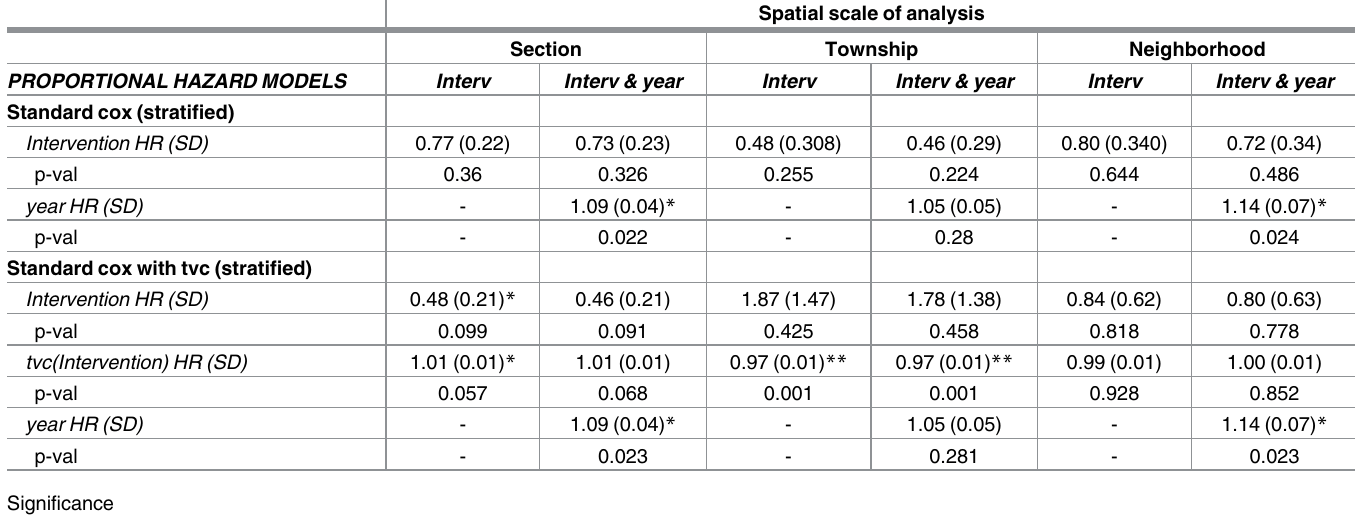
Table 3. Main results of Cox models measuringrisk of recurrencebetween treatments(lethal and non-lethal) implemented after wolf depredations, for all spatial